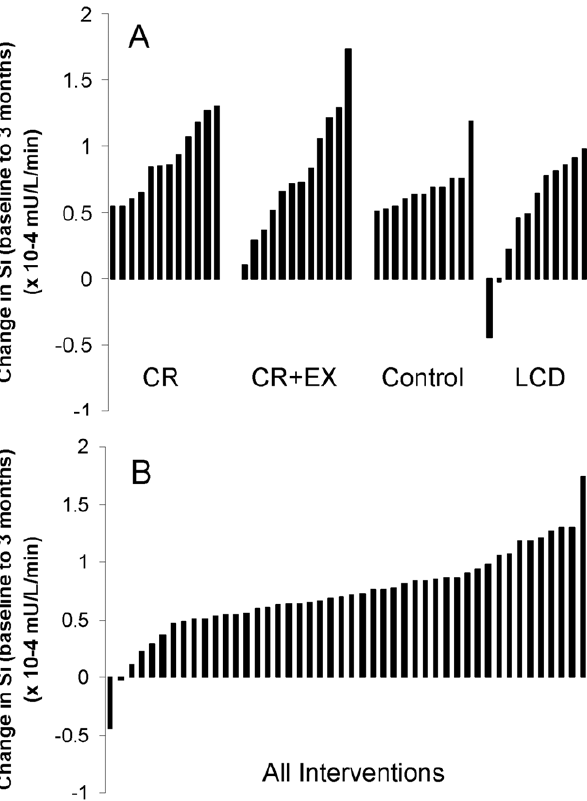
Figure 3. Baseline to Month Three Changes in Insulin Sensitivity: Average Group Improvements Despite Varied Individual Responses. Each bar represents insulin sensitivity improvements for participating individuals. A. By intervention group. CR=Caloric restriction; CR + EX=Caloric restriction with exercise; Con- trol=Healthy weight maintenance diet; LCD=Liquid calorie diet B. Intervention groups combined.